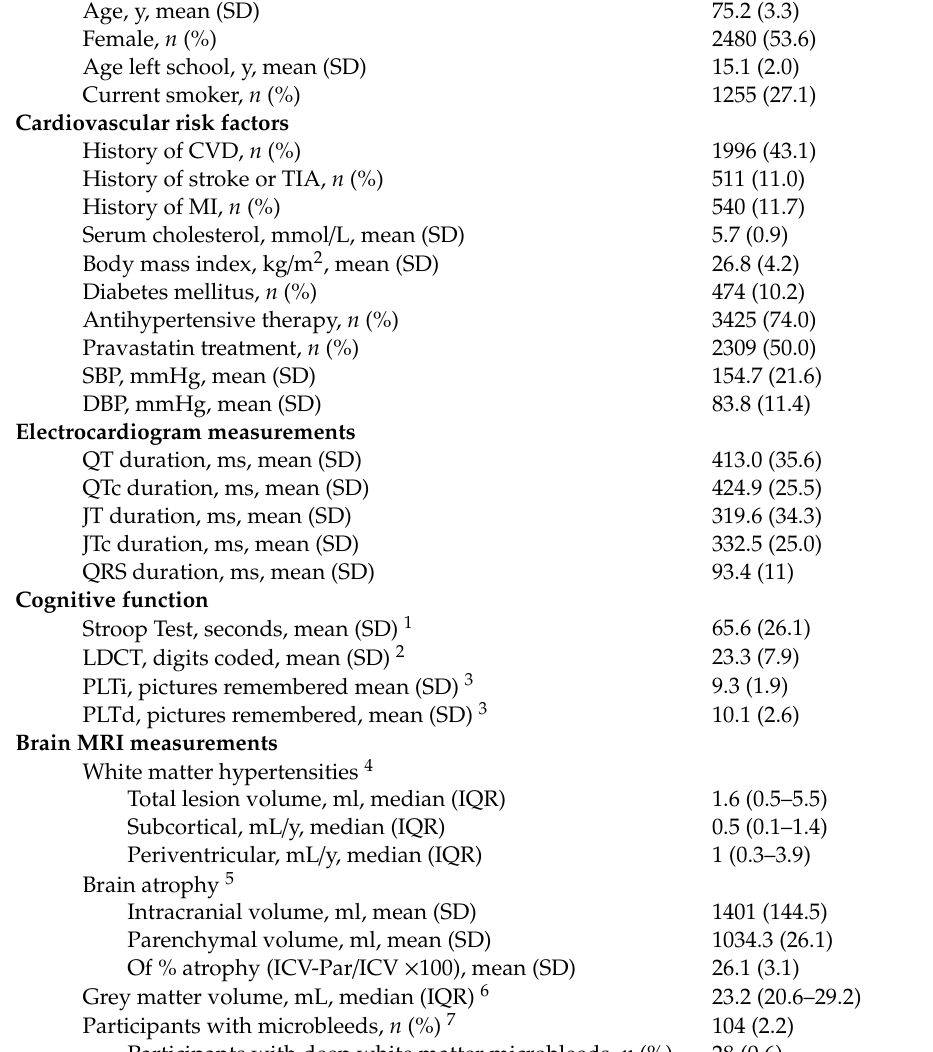
Table 1. Demographic and clinical characteristics of study population ( n =